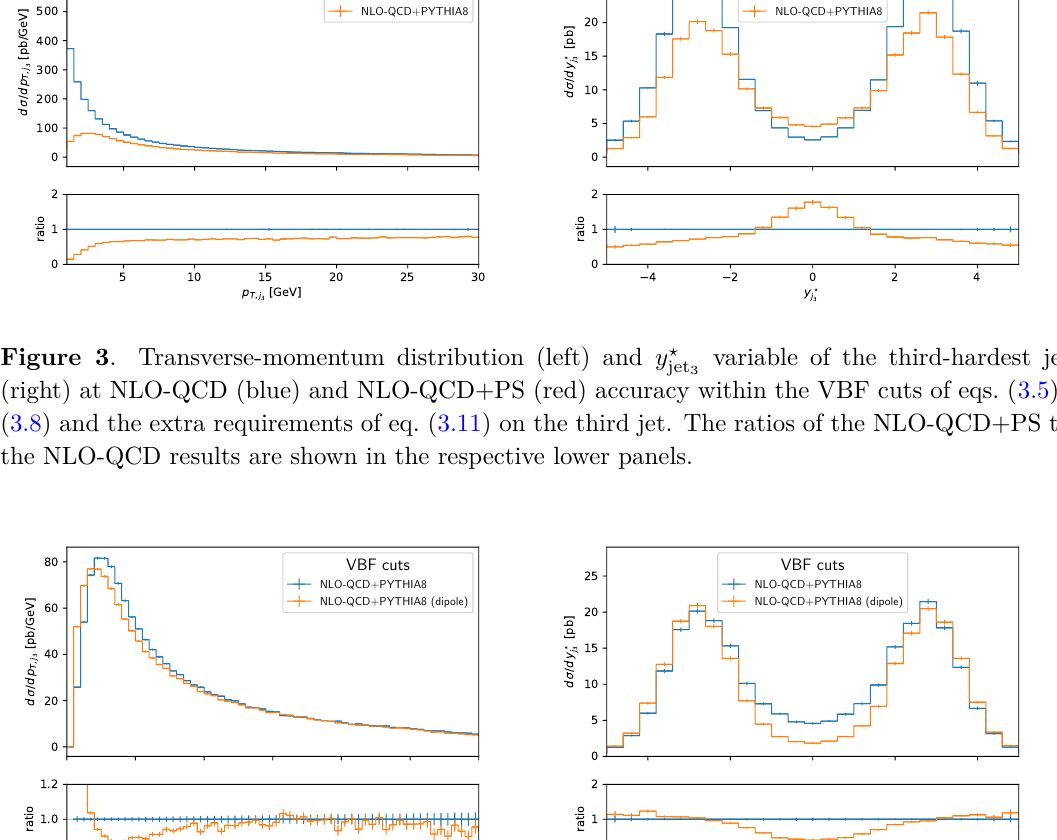
Figure 4 . Transverse-momentum distribution (left) and y ? (right) at NLO-QCD+PS accuracy with the default global recoil scheme (blue) and the dipole recoil scheme (red) of PYTHIA8 within the VBF cuts of eqs. (3.5)–(3.8) and the extra requirements of eq. (3.11) on the third jet. The ratios of the dipole to the default shower results are shown in the respective lower